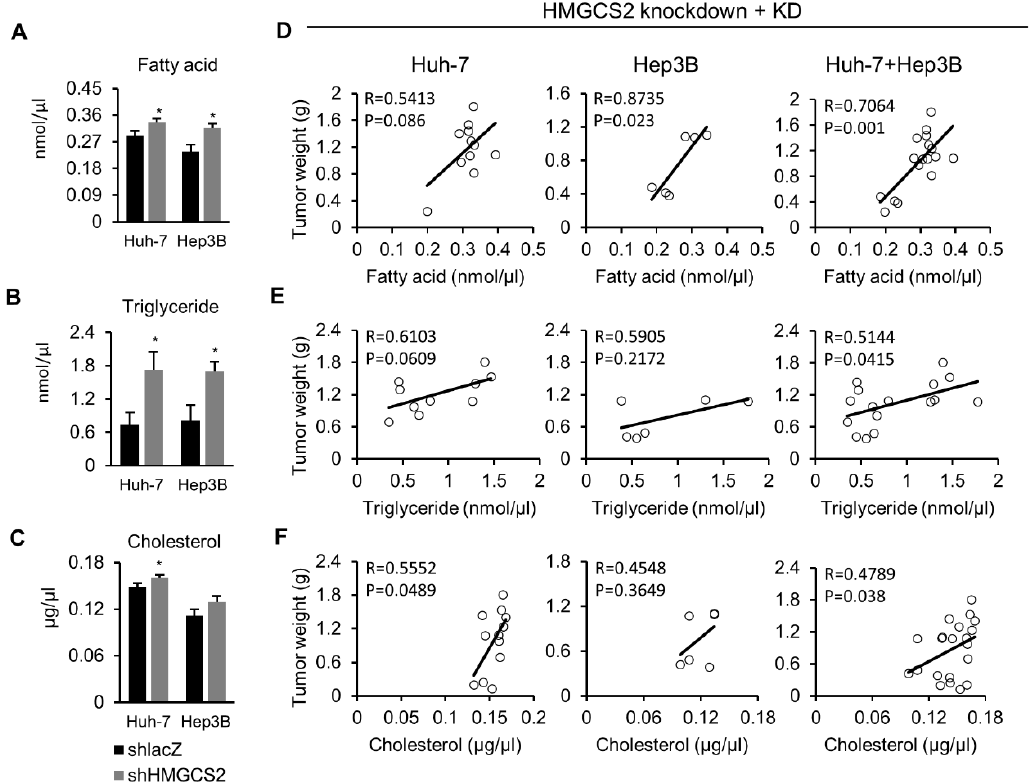
Figure 6. HMGCS2-downregulated tumors showed elevated lipid content and positively correlated with tumor weight. ( A – C ) The fatty acid, triglyceride, and cholesterol in the tumor mass. ( D – F ) Pearson correlation between each lipid content and tumor weight in the indicated groups. The Mann–Whitney U test was used to compare two independent groups. * p < 0.05 vs. the black bar.